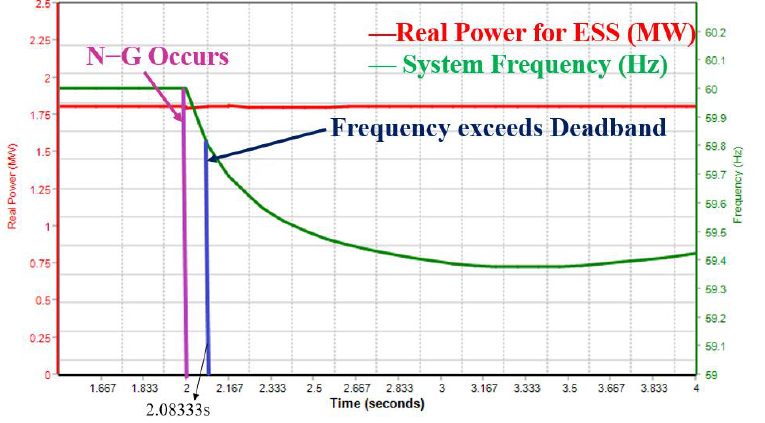
Figure 8. Grid frequency and real power output when contingency occurs during ESS2 and ESS3 discharge.